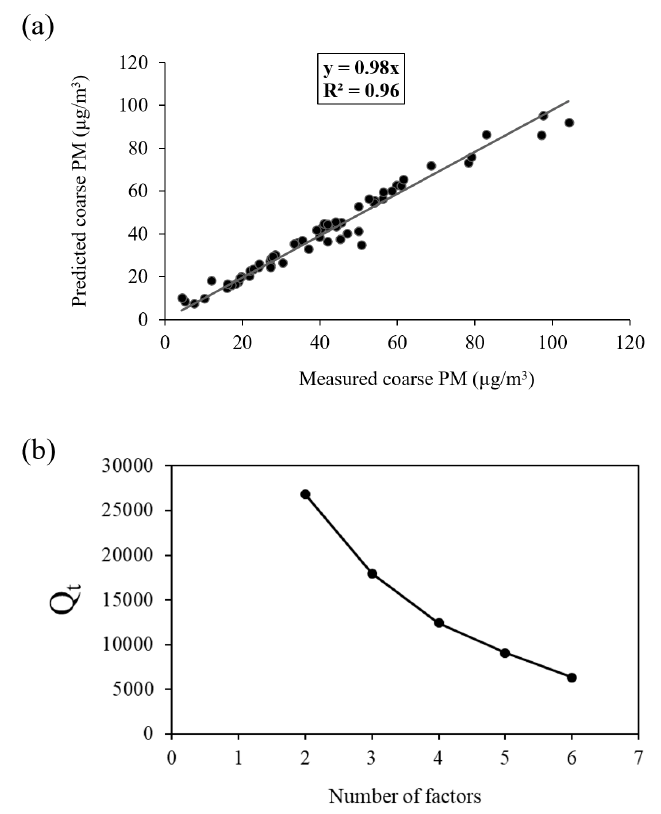
Figure 4. ( a ) Correlation between measured and predicted coarse PM; and ( b ) Q t (true objective function) versus number of factors.